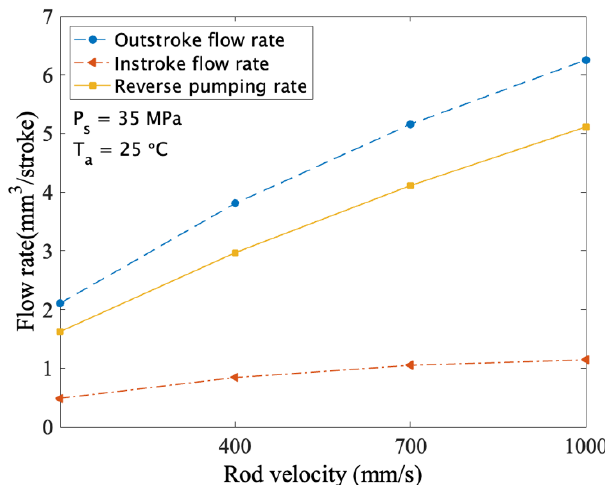
Figure 5. Film thickness distribution at different rod velocities (mm/s), 35 MPa, and 25 ℃ : ( a ) out- stroke and ( b ) instroke.